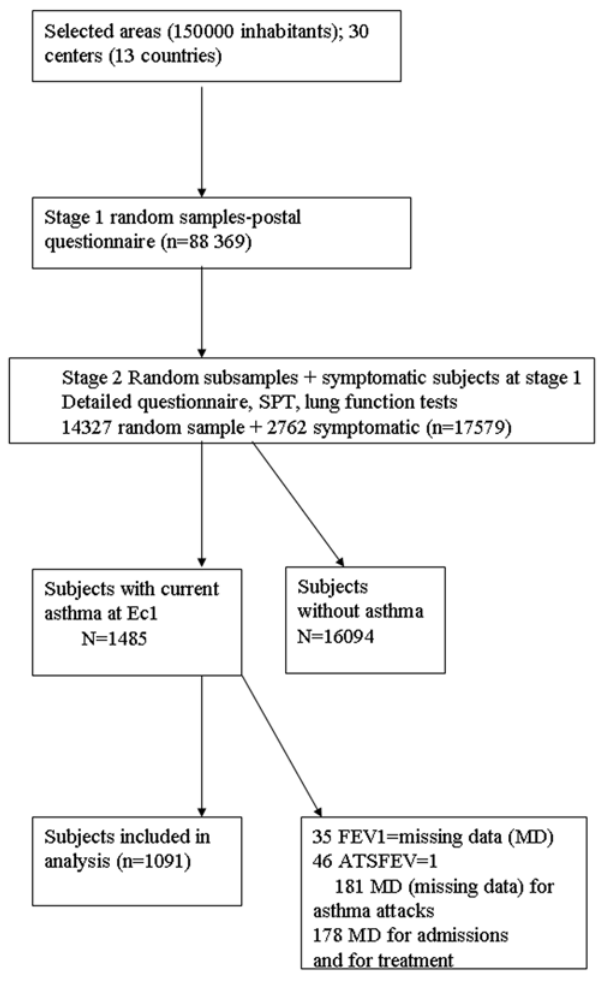
Figure 1. Study design.